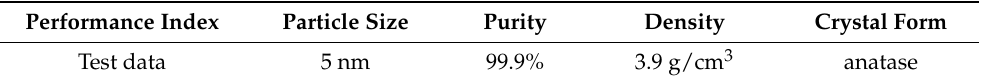
Table 3. Basic performance indexes of nano-TiO 2 .